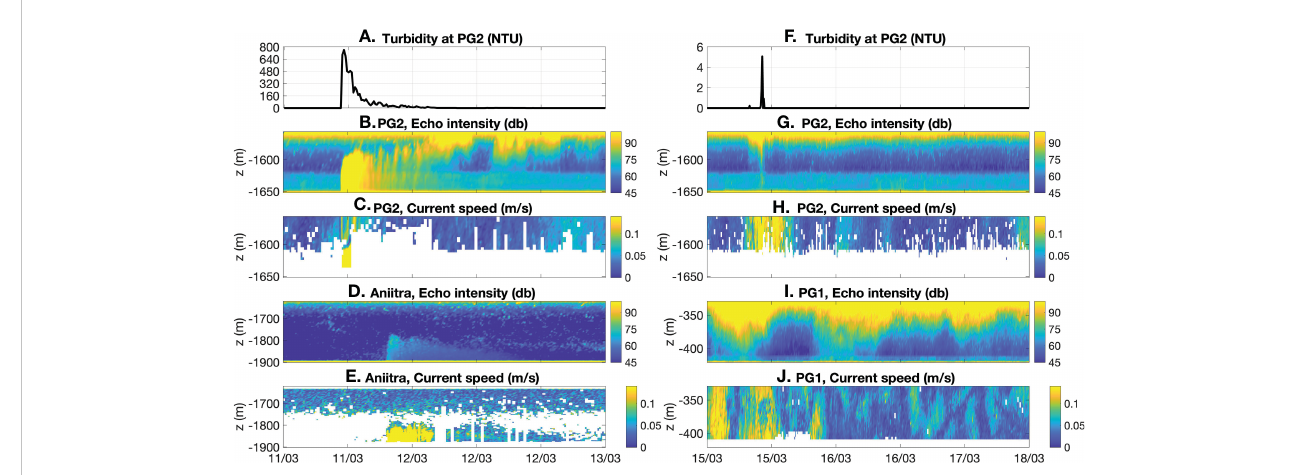
FIGURE 10 From March 11th to March 13th: (A) Turbidity (NTU), (B) echo intensity (db) and (C) current speed (m s-1) measured by the PG2 mooring and (D) echo intensity (db) and (E) current speed (m s-1) measured by the Aniitra mooring. From March 15th to March 18th: (F) Turbidity (NTU), (G) echo intensity (db) and (H) current speed (m s-1) measured by the PG2 mooring and (I) echo intensity (db) and (J) current speed (m s-1) measured by the PG1 mooring.